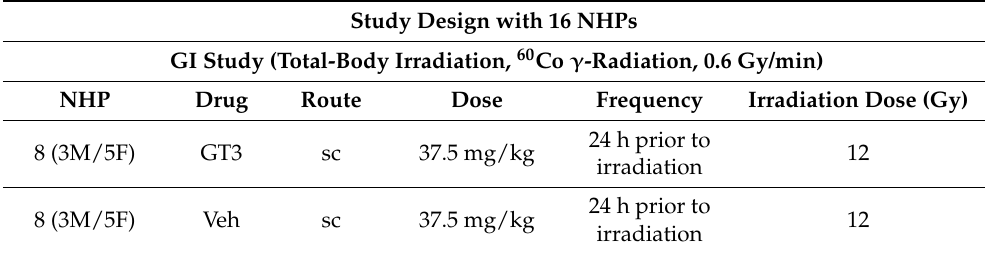
Table 1. Experimental study design for 16 NHPs exposed to 12 Gy